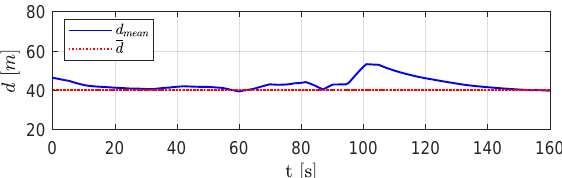
Figure 9. Scenario #1—three aircraft: mean distance between visible aircraft (blue solid line) compared with desired distance (red dotted